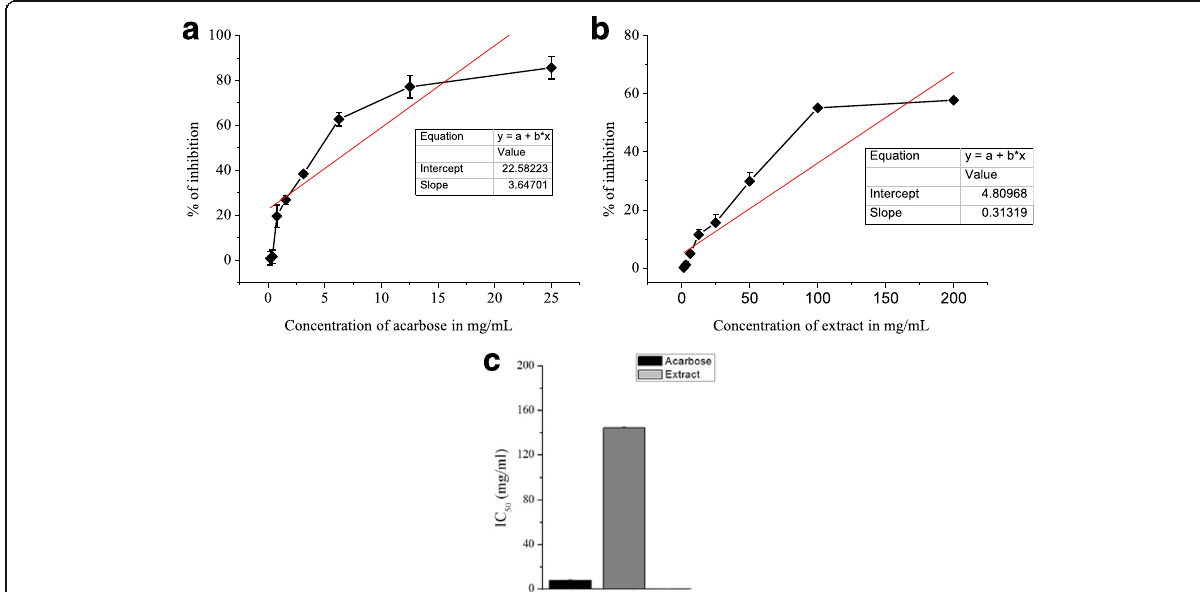
Fig. 2 α -amylase inhibition activity of acarbose and C. crepidioides in DNSA assay. a Percentage inhibition of acarbose ( b ) 80% methanol extract of C. crepidioides and ( c ) IC50 of treatment groups on α -amylase enzyme in vitro. Values were represented as mean ± SD ( n = 3)